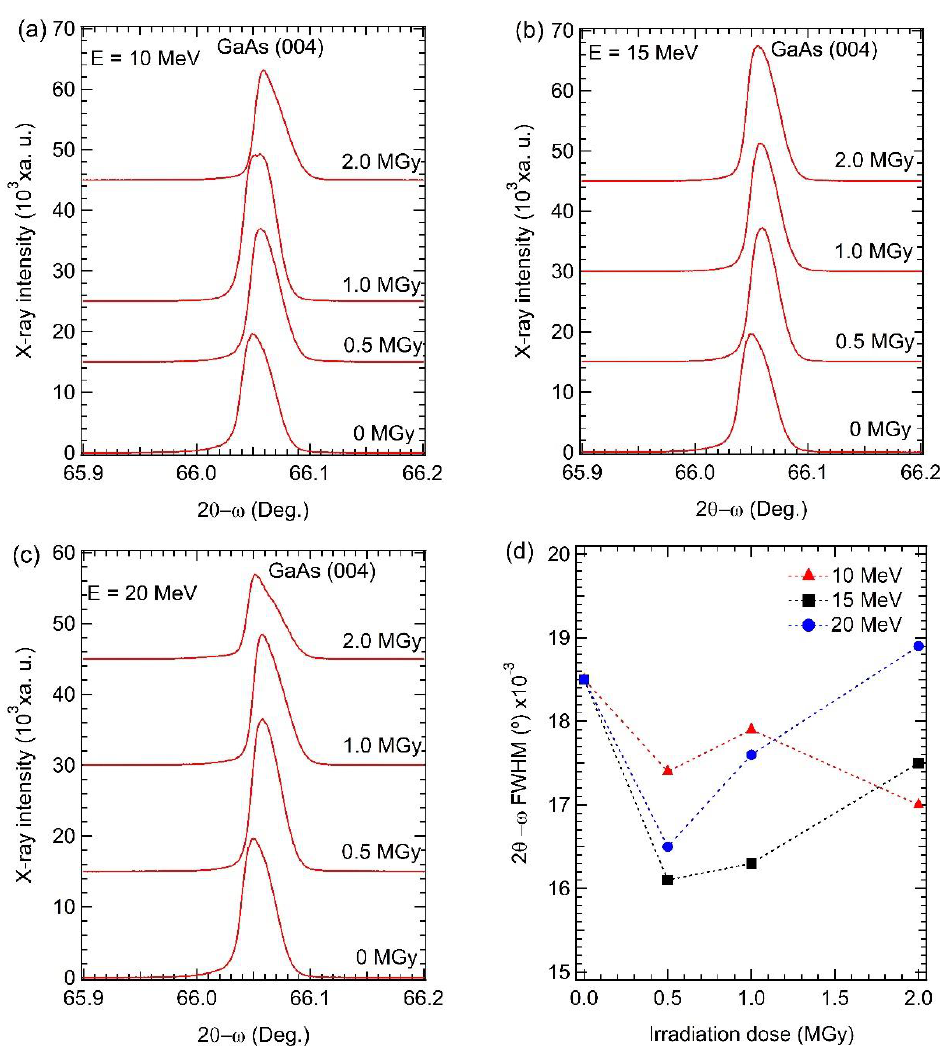
Figure 5. Symmetric (004) 2 θ - ω curves of the non-irradiated and the irradiated GaAs with different irradiation strengths at an electron energy of ( a ) 10; ( b ) 15, and ( c ) 20 MeV; ( d ) The full width at half maximum (FWHM) of GaAs (004 ) peak.